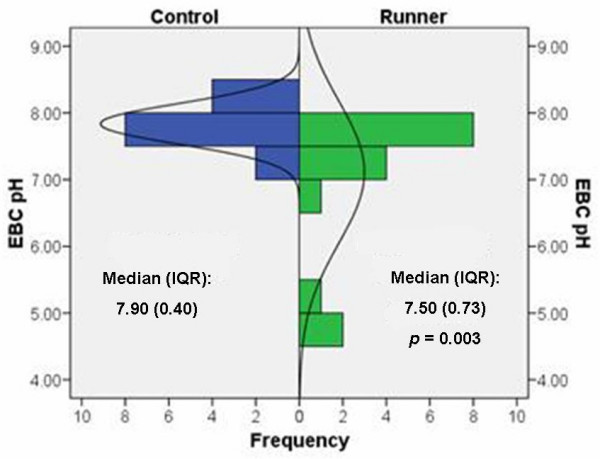
Outdoor resting breath pH was lower in runners (n = 16; green) compared to controls (n = 14; blue). Observed outdoor resting breath pH in this group of adolescent runners was lower than that seen in a control group of non-smoking, healthy adults, none of whom were involved in regular long-distance outdoor running (p = 0.003 by Mann-Whitney U test).